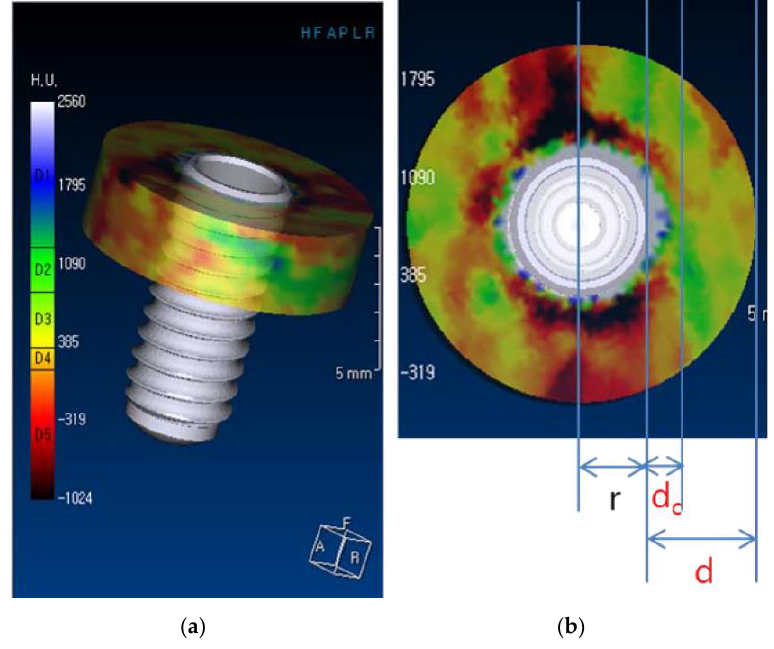
Figure 2. Main and error correction cylinders: ( a ) main cylinder (height = 3 mm) and ( b ) cross-sectional views of the main cylinder and error correction cylinder (r = implant radius, d = 3 mm, and dc = 1 mm).